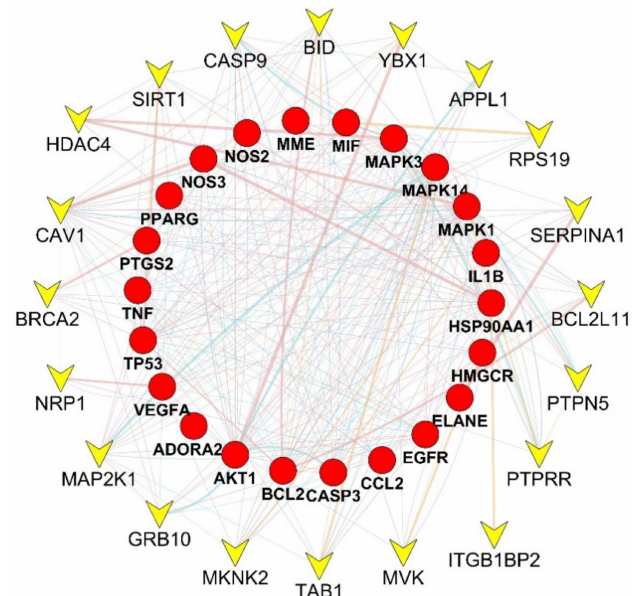
Figure 1. Network of potential targets of genistein against PH analyzed by GeneMANIA. Genes on the inner ring were submitted as query terms in searches. Nodes on the outer ring indicate genes associated with query genes. Functional association of targets was analyzed, and di ff erent color of connecting lines represent di ff erent